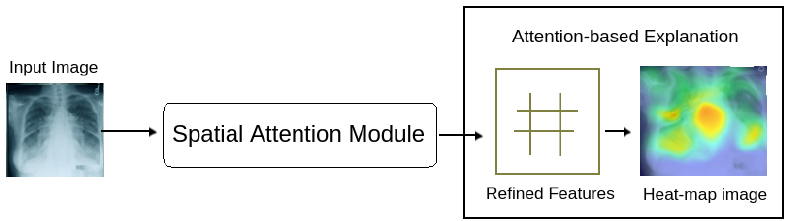
Figure 4. Attention-based explanation. The refined features are highlighted through attention feature maps and represented via a heat map